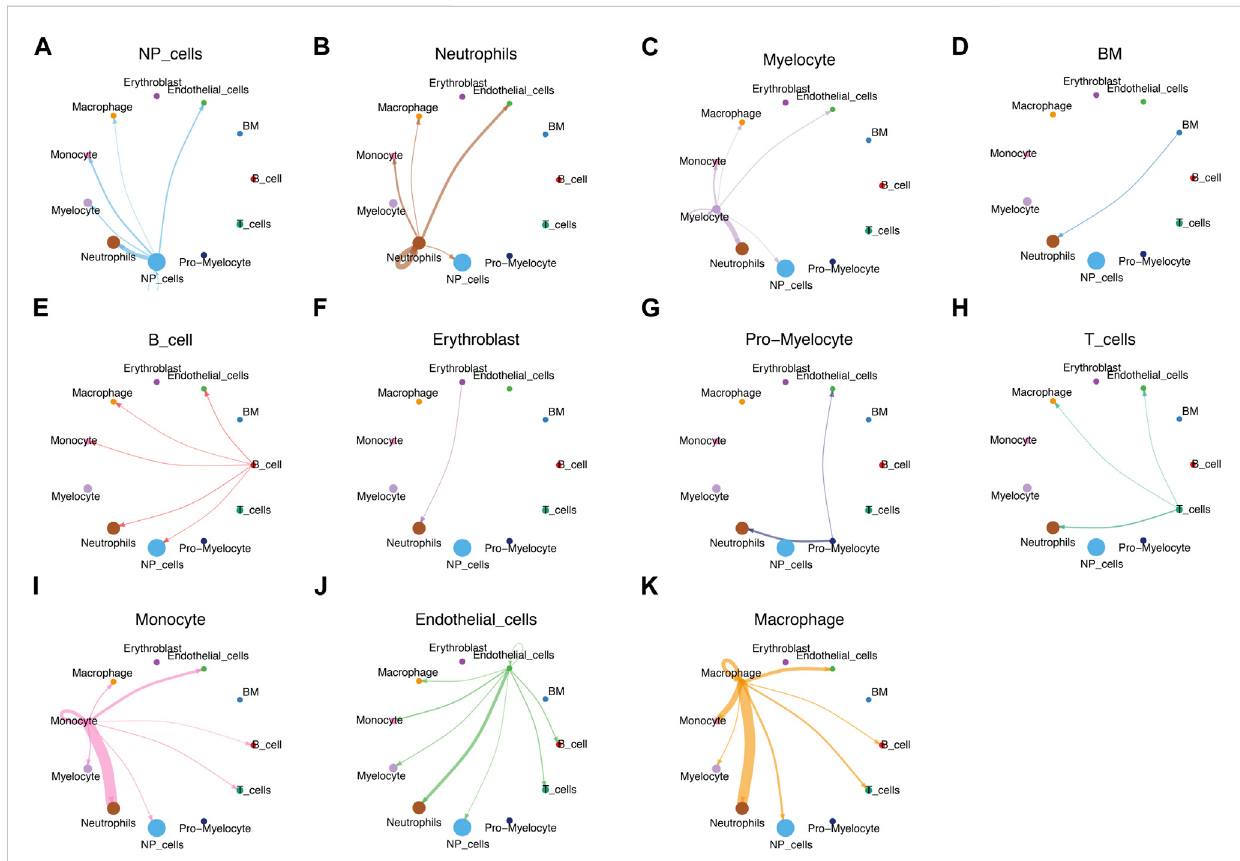
FIGURE 8 CellChat analysis. (A – K) Circle plots demonstrated the interactions in the cell-cell communication network between IVD degeneration and healthy subjects,